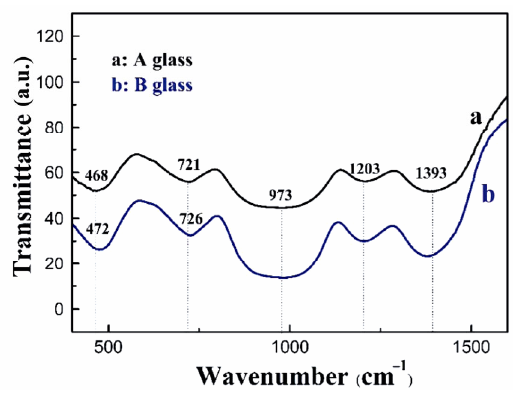
Fig. 1 FTIR spectra of A and B glass with different Al 2 O 3